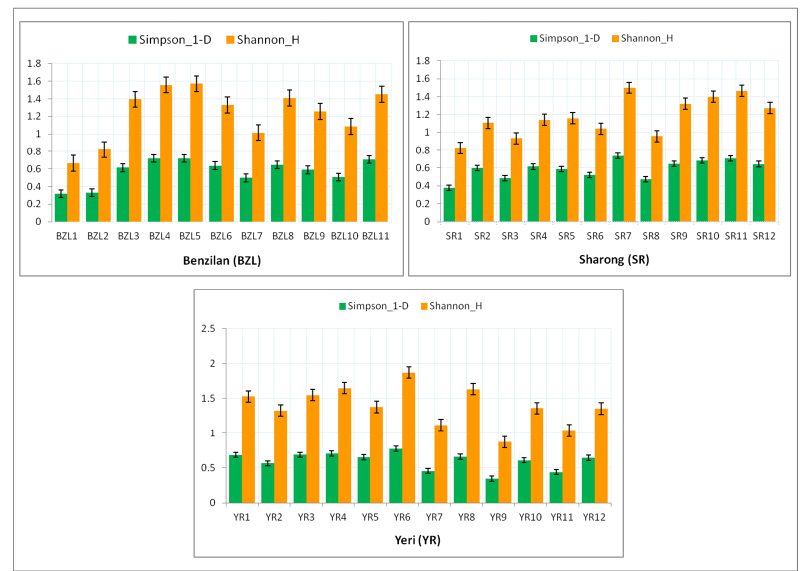
Figure 5. Diversity indices of mayfly taxa at various sites of the three streams. The error bars signify the standard error of average values.